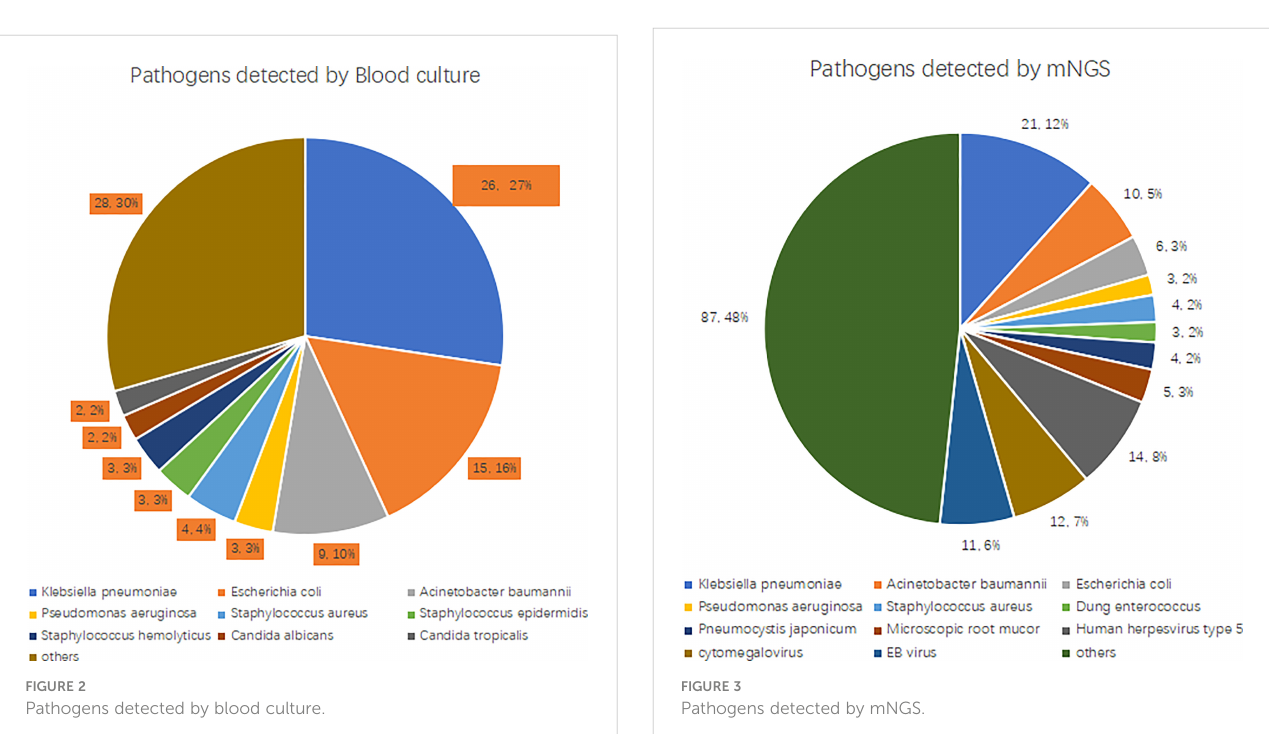
FIGURE 2 Pathogens detected by blood culture.